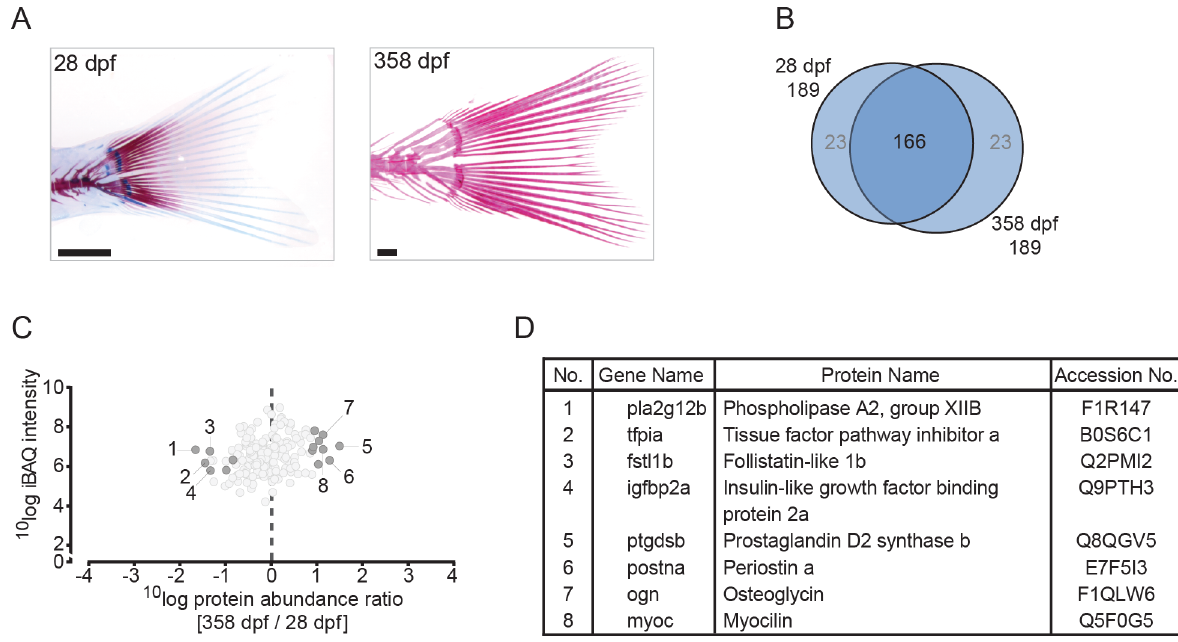
Figure 4. Quantitative analysis of the zebrafish caudal fin by MS-based proteomics. (A) Alcian blue/alizarin red stain of cartilage/bone structures in the caudal fin skeleton. Lateral images of two time points used for protein extraction (left to right: 28 dpf, 358 dpf). (B) VENN diagram of proteins selected for label-free quantification, with areas drawn to represent the number of proteins. Total number of proteins as well as distinct and common proteins are indicated for each time point. Proteins that did not qualify for label-free quantification are depicted in grey. (C) Ratio abundance plot showing log total iBAQ intensities versus log protein abundance ratio of the 358/28 dpf caudal fin region ratios of all the proteins that met the strict criteria for label-free quantification (dark grey circles, significantly differential abundant proteins at FDR= 0.05; light grey circles, no significant change in abundance). The numbers correspond to the proteins listed in 4D. (D) Table containing several of the significant differentially abundant proteins within the cranial skeleton. Specific proteins are discussed in the